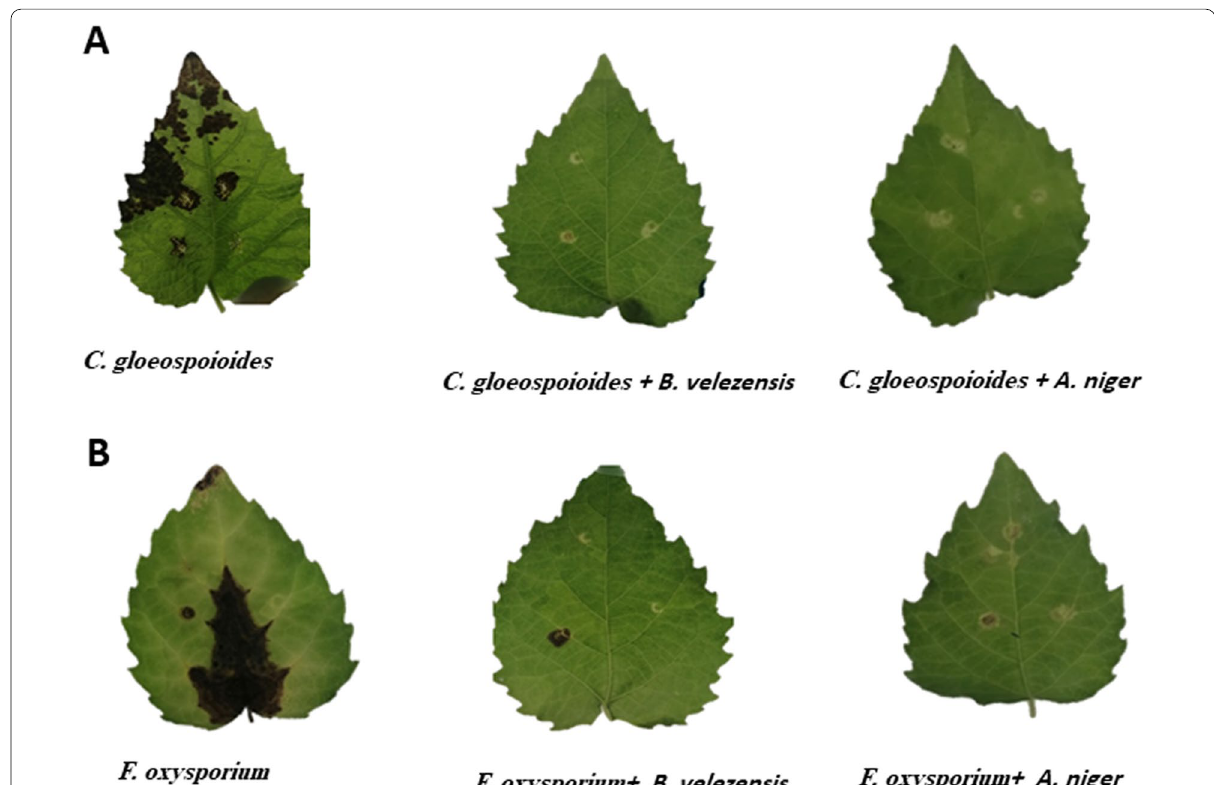
Fig. 5 Photo of biocontrol efficacy of Bacillus velezensis 33RB and Aspergillus niger 46 SF against Colletotrichum gloeosporioides BJ02 and Fusarium oxysporum 20RF. A Spore suspension of C. gloeosporioides BJ02 was applied firstly then sterilized cultural filtrate of B. velezensis 33RB, A. niger 46SF was applied to the same place . B Spore suspension of F. oxysporium 20RF was applied firstly then sterilized cultural filtrate of B. velezensis 33RB, A. niger 46SF was applied to the same